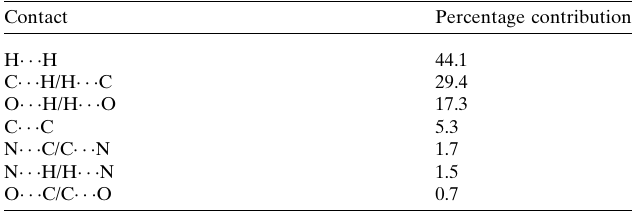
Table 3 Percentage contributions of interatomic contacts to the Hirshfeld surface for the title compound.